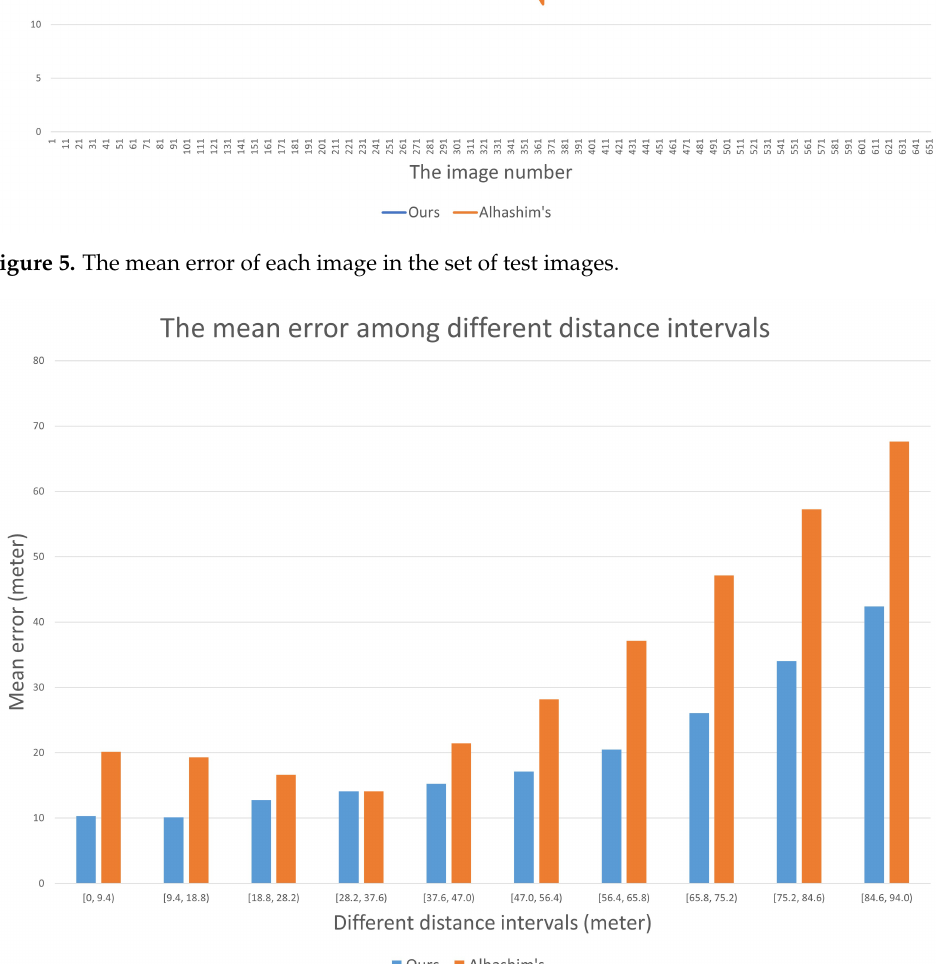
Figure 6. The mean error for various distance